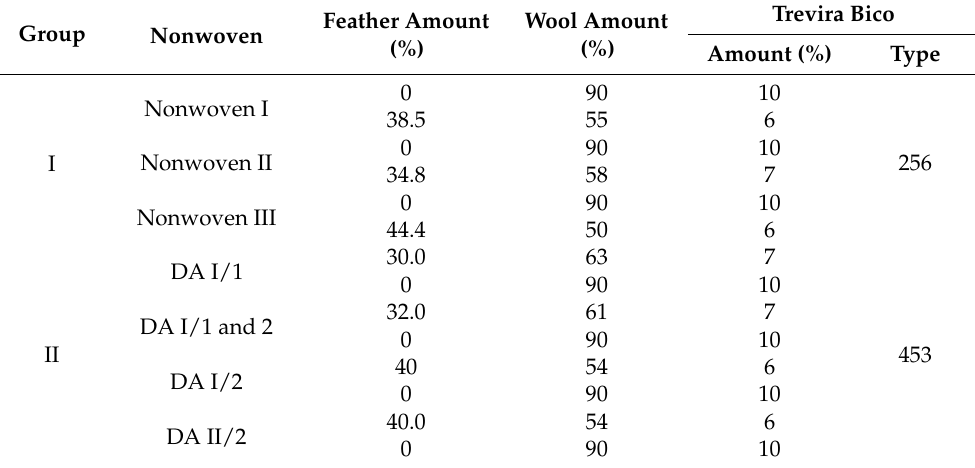
Table 1. The compositions of the tested nonwovens. Feather Amount Group Nonwoven